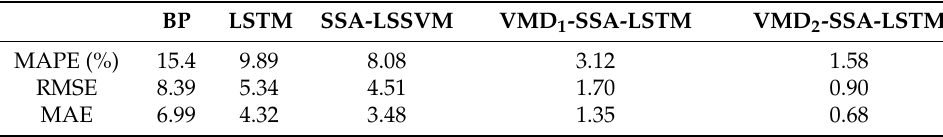
Figure 8. France forecast error indicators. Table 2. Error metrics for different prediction models in French.